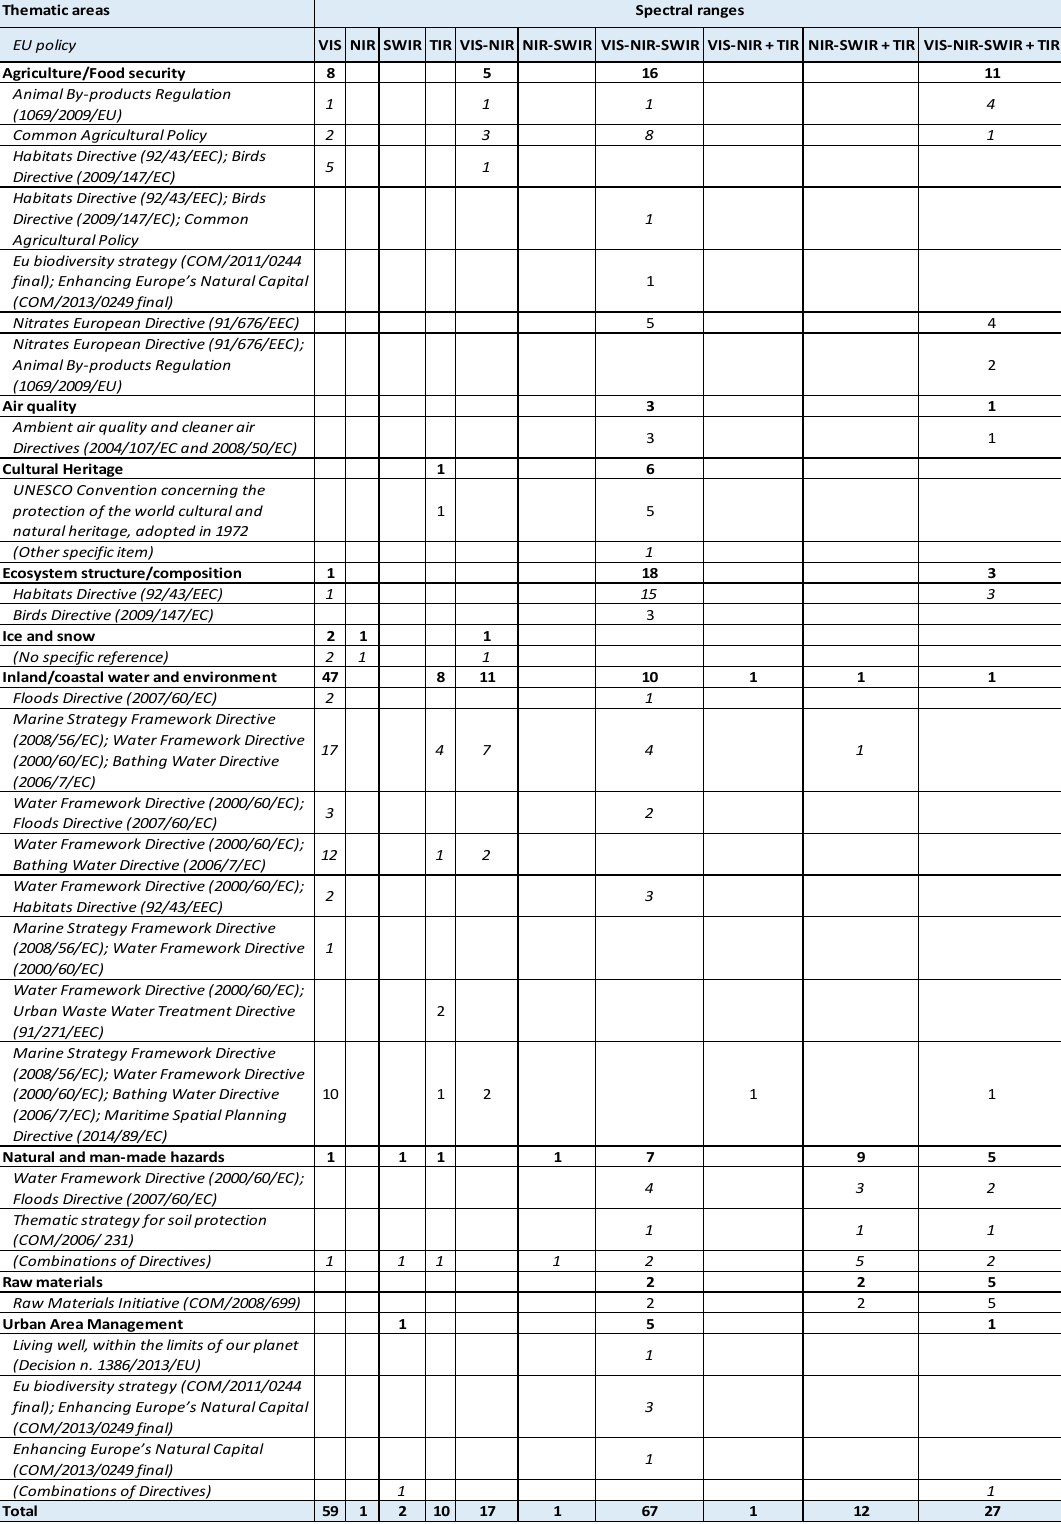
Table A2. Frequency of spectral range classes covered by the hyperspectral layers that match for each thematic area the parameters requested by the user communities (figures reported in bold). For each thematic area, frequencies are also aggregated at the EU policy level (figures reported in italic).